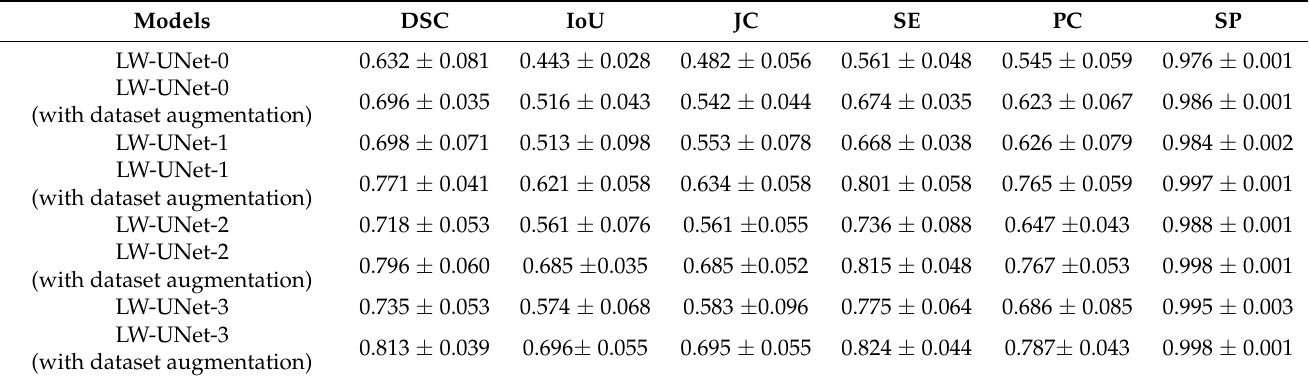
Table 3. The ablation analysis validates the effectiveness of our data